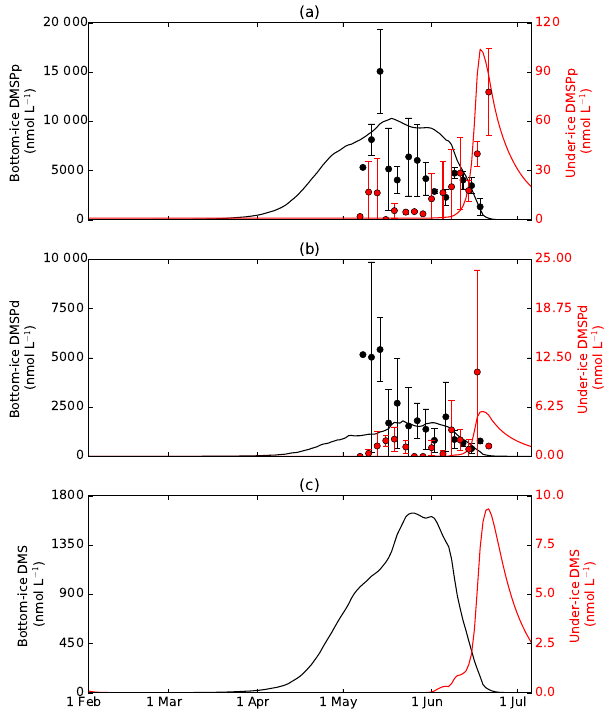
Figure 3. Simulated (lines) and observed (dots and bars) time series of (a) DMSPp, (b) DMSPd, and (c) DMS concentrations (nmolL − 1 ) in the bottom 3cm ice (black) and averaged over the upper 10m water column (red) in Resolute Passage during 2010. The observed bottom-ice values show the average (black dots) and 1 standard deviation (vertical bars) of samples collected in ice cores under high, medium, and low snow cover sites. The observed upper 10 m water column values show the average (red dots) with ± 1 stan- dard deviation (vertical bars) of samples collected in seawater at 1.5, 2, 5, and 10m